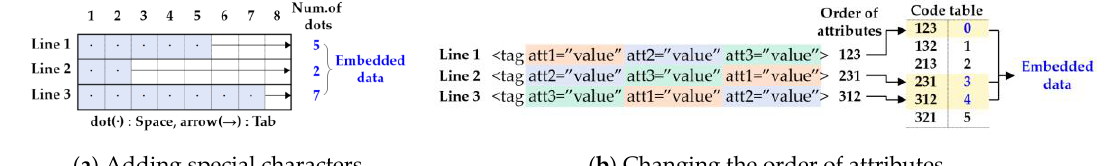
Figure 2. Webpage steganography methods used by Platinum [7].